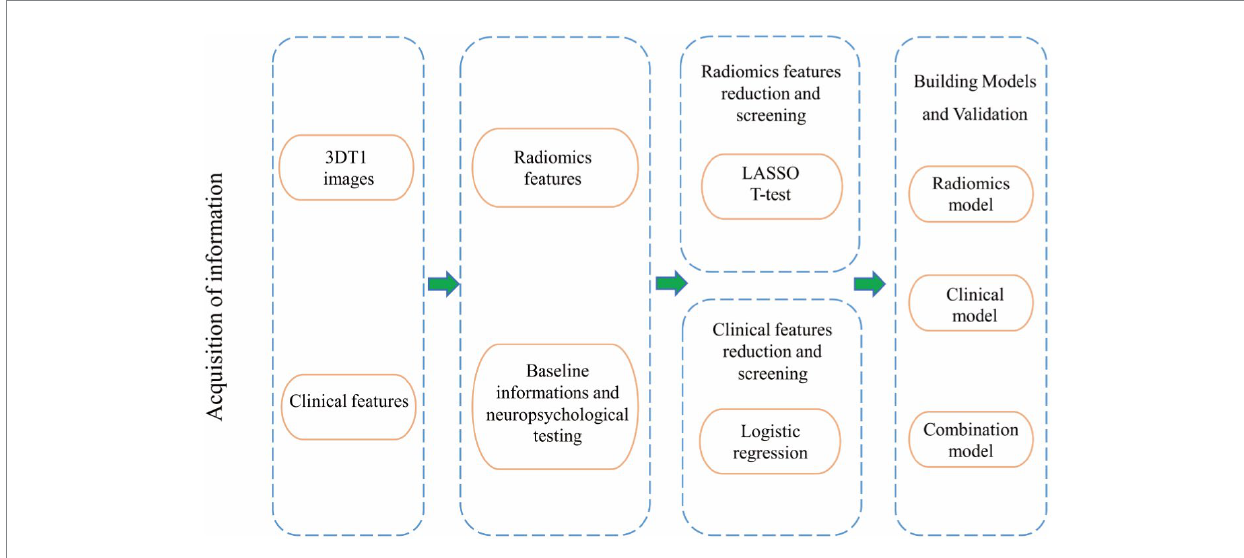
FIGURE 2 Flow chart of the study design.